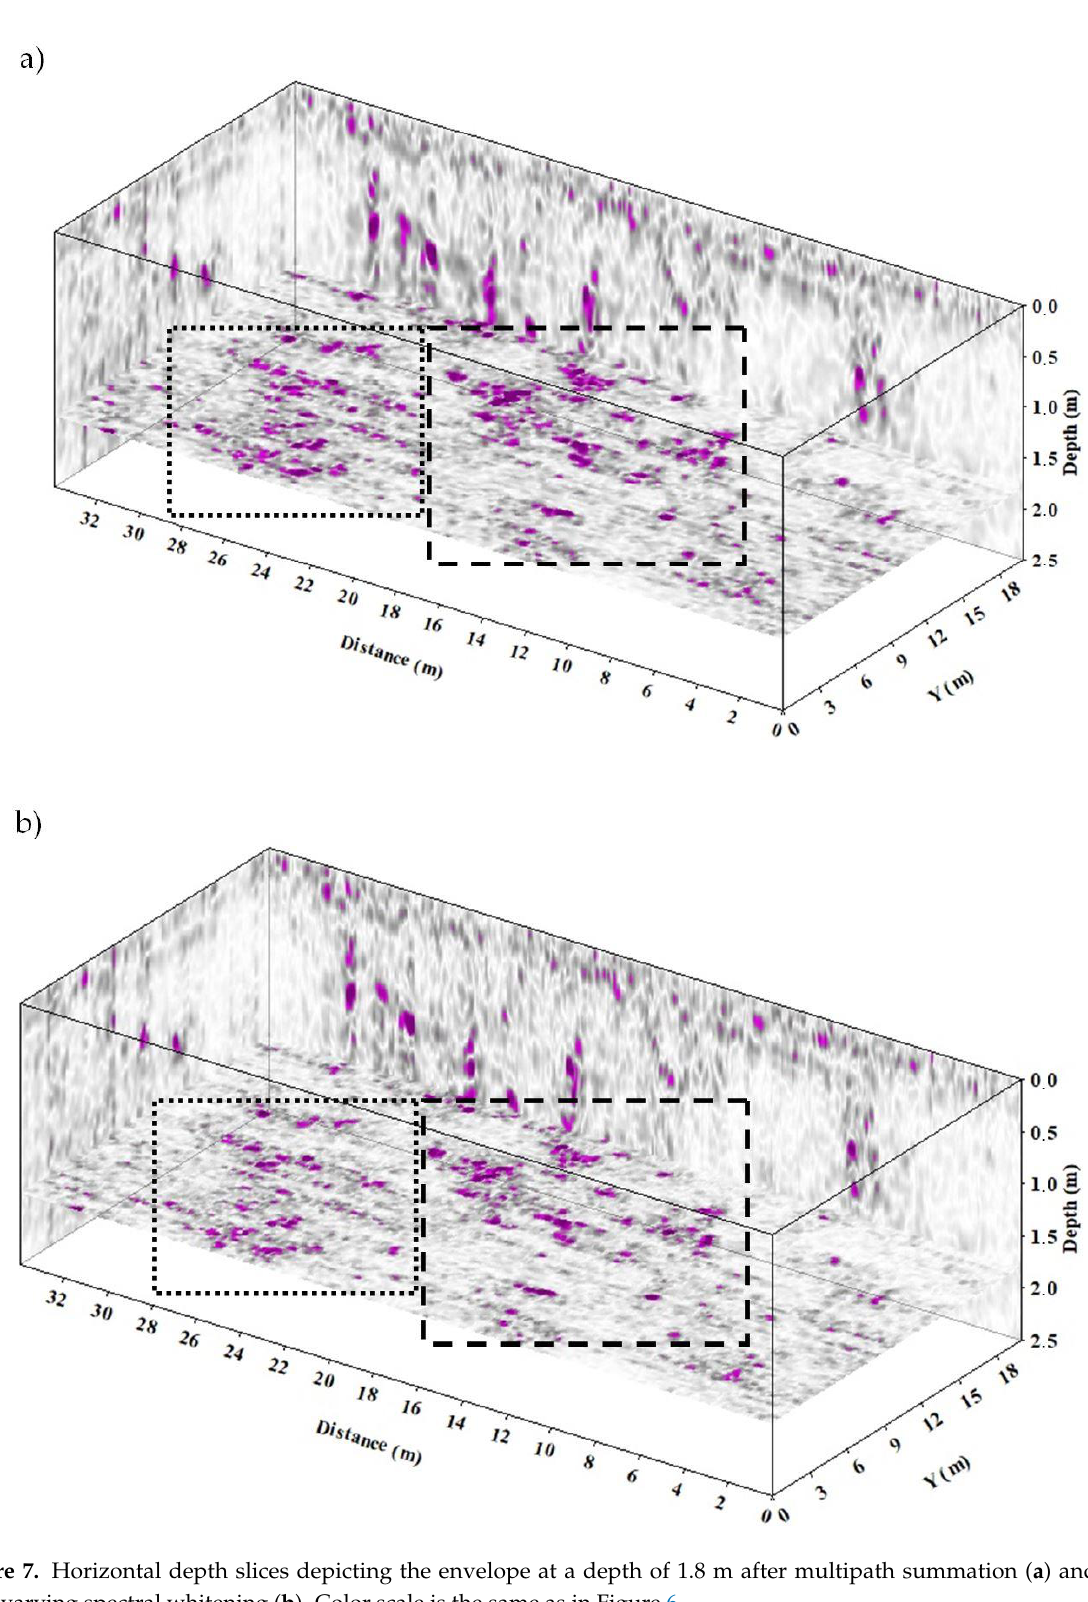
Figure 7. Horizontal depth slices depicting the envelope at a depth of 1.8 m after multipath summation ( a ) and after time-varying spectral whitening ( b ). Color scale is the same as in Figure